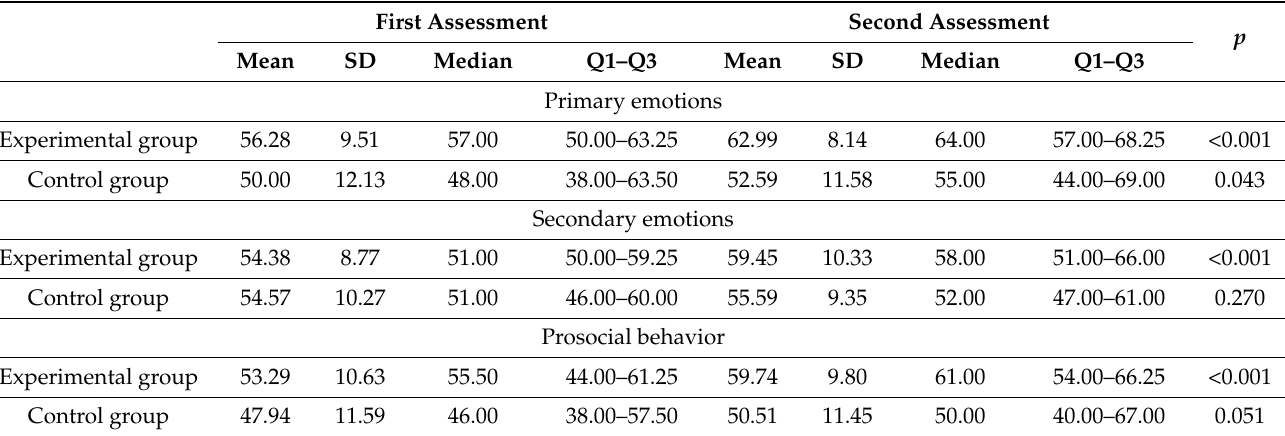
Table 10. Changes in the results of the EMK 3–6 in the experimental and control groups, comparing the data of the first and second